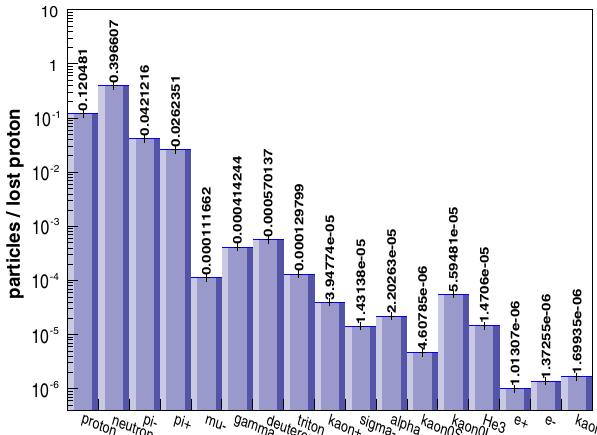
FIG. 5. Contribution of each particle type to the magnets activation due to proton beam losses in the beam pipe.